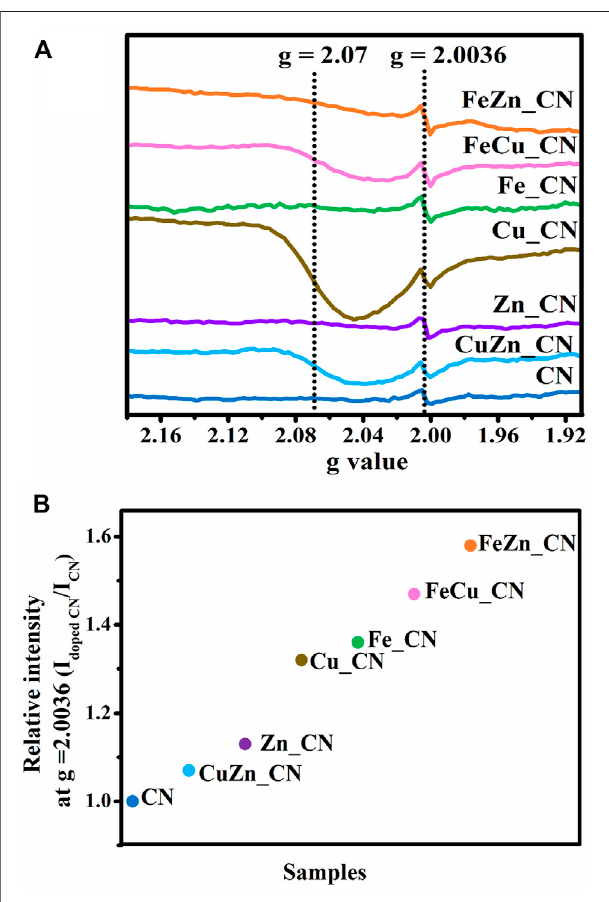
FIGURE 4 | (A) ESR spectra of undoped CN and metal-doped CN at room temperature and (B) increase in relative intensity at g = 2.0036.